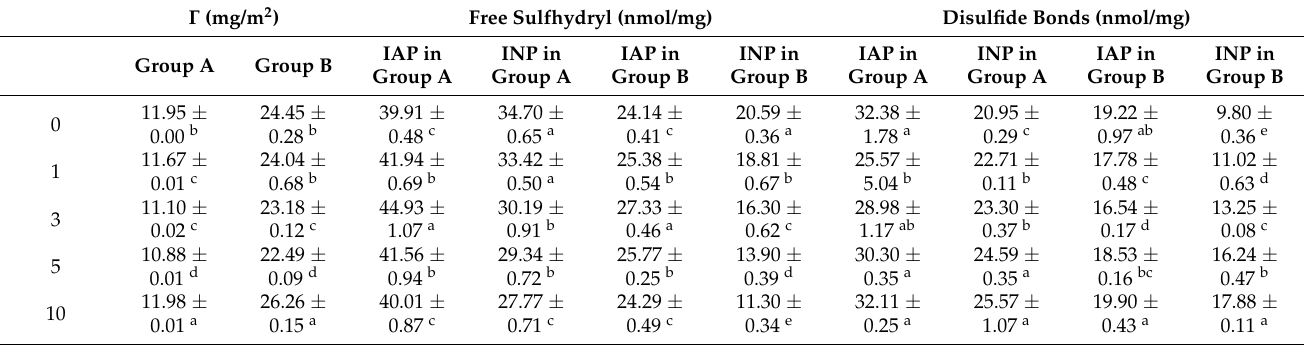
Table 2. Effects of ultrasonic intensity on the content of IAP and free sulfhydryl and disulfide bonds of IAP and